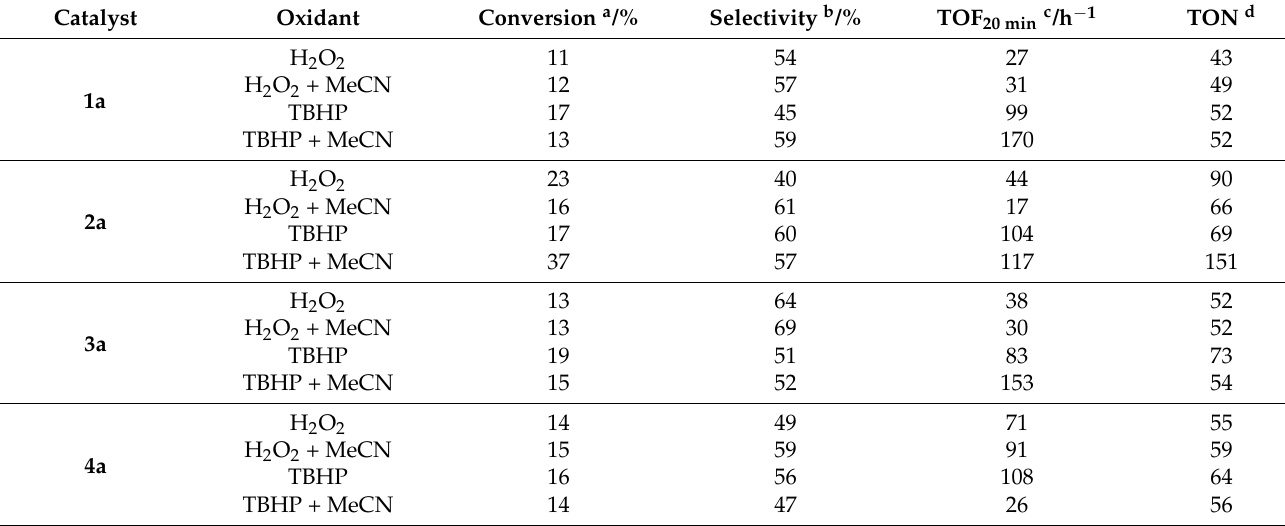
a butan-2-ol consumed at the end of reaction. b formed epoxide per converted olefin at the end of reaction. c n (butan-2-ol) trans- formed/ n (catalyst)/time(h) at 20 min. d n (butan-2-ol) transformed/ n (catalyst) at the end of